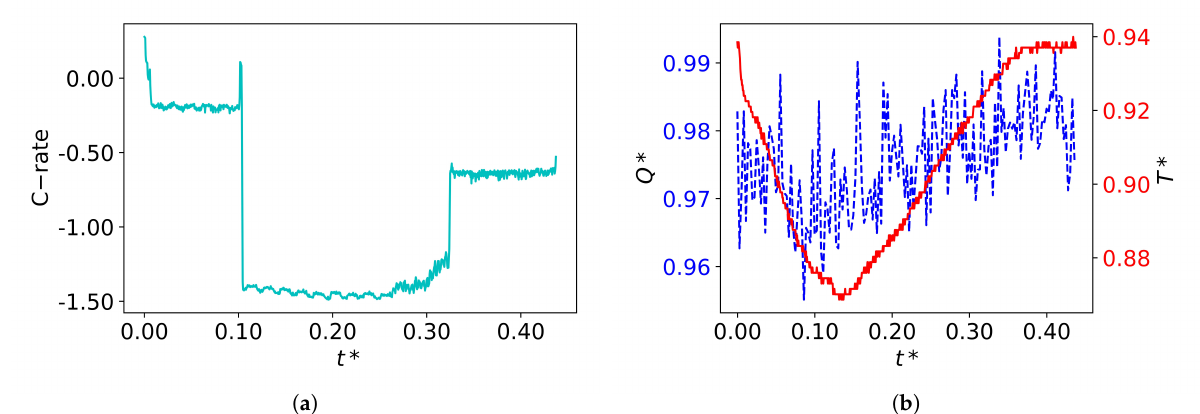
Figure 3. Case 2 test scenario: ( a ) Current profile and ( b ) inlet volumetric flow rate ( Q ∗ ) and temperature of the coolant ( T ∗ ) .